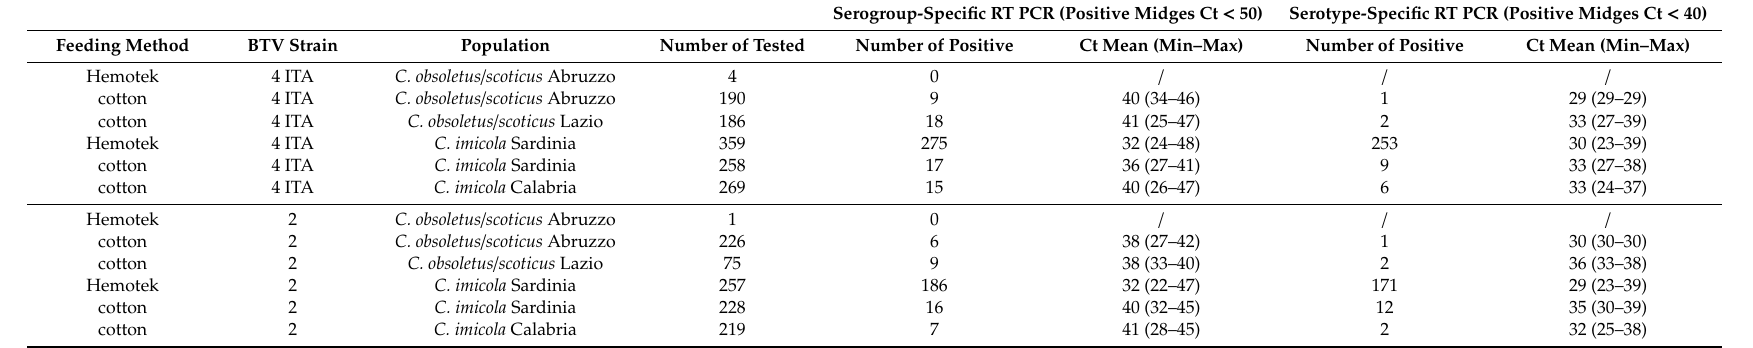
Table 4. Virus detection in Culicoides (heads) fed on BTV-infected blood at 10 days